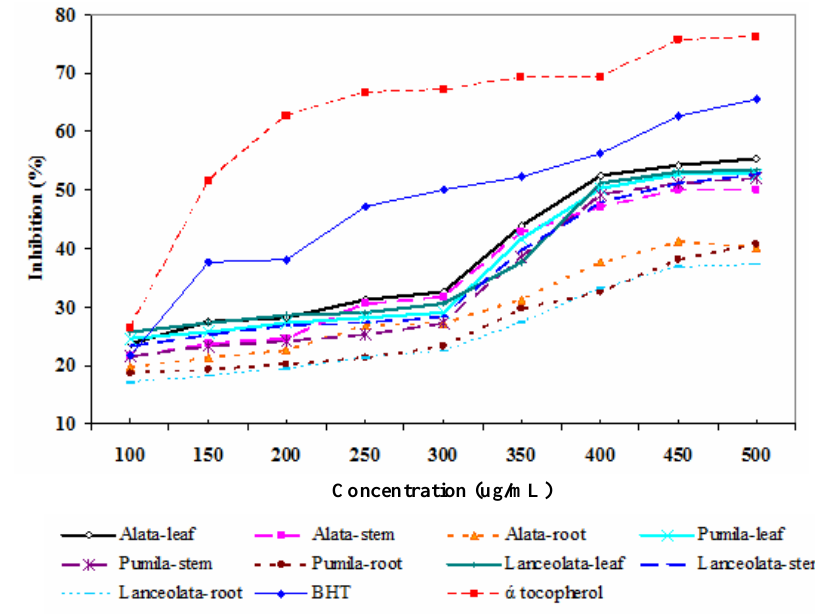
Figure 1. DPPH radical scavenging activity in different parts of three varieties of L. pumila compared to the positive controls, BHT and α -tocopherol.